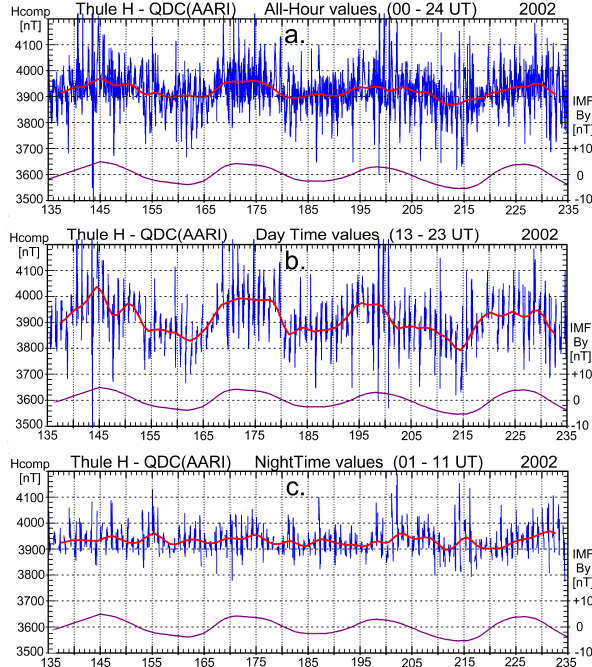
Figure 3. Data 2002. Thule H -comp – QDC(AARI) in blue line for: (a) all hours, (b) daytime, (c) night-time hours. Smoothed median values in red line. IMF B y in magenta line (scale to the